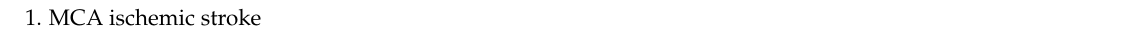
Table 2. Key inclusion criteria (TOOTH